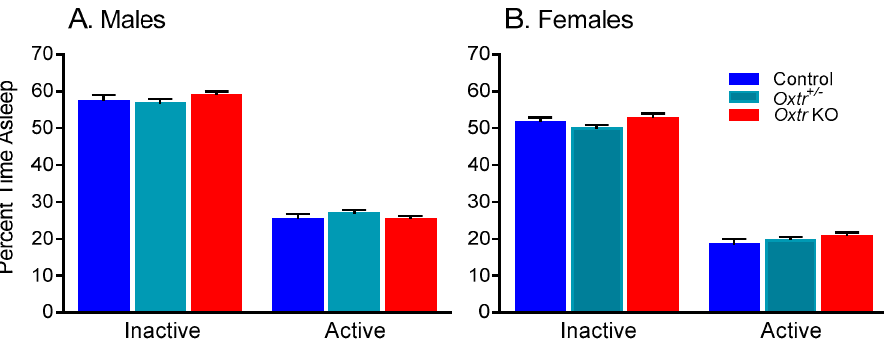
Figure 2. Sleep duration in oxytocin receptor ( Oxtr ) Oxtr knockout (KO), Oxtr +/ − , and control male ( A ) and female ( B ) mice. We found statistically significant main effects of phase and sex, but no statistically significant interactions or main effects of genotype (Table 1). Mice slept less in the active phase compared to the inactive phase ( p < 0.001). Females slept less than males ( p < 0.001). Bars represent means ± SEM for 23 control male, 21 Oxtr +/ − male, 22 KO male, 14 control female, 31 Oxtr +/ − female, and 21 KO female mice.